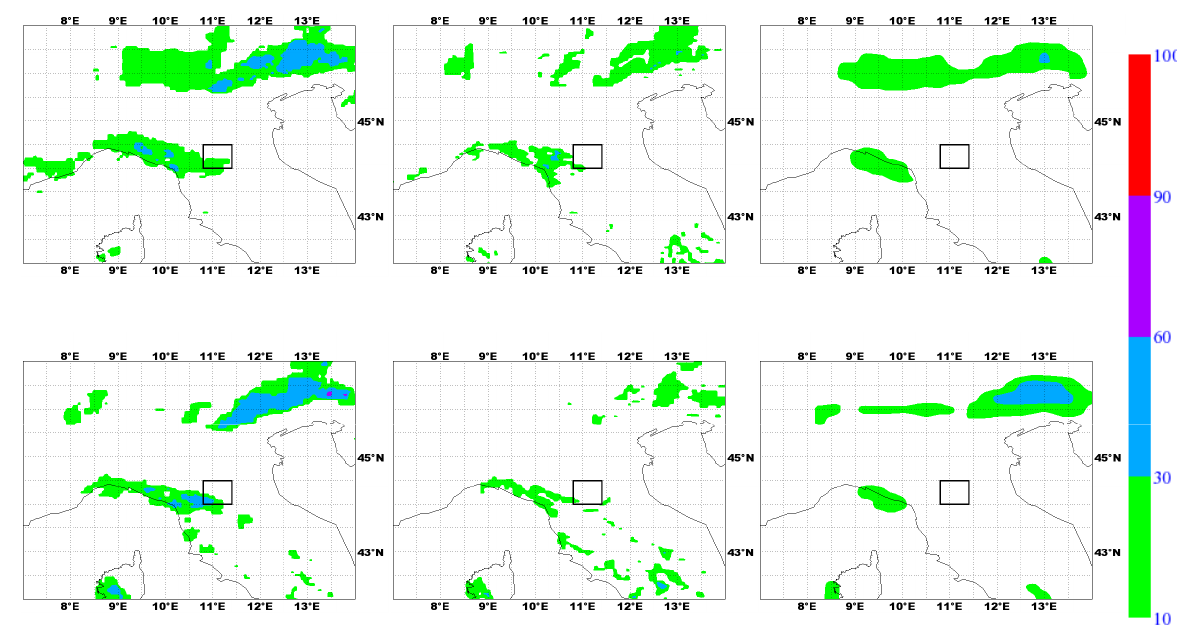
Fig. 5. Maps of probability of precipitation exceeding 50mm in 24h obtained at + 120h (top panels) and + 72h (bottom panels) forecast range: multi-model (left), COSMO-LEPS (middle) and ECMWF global EPS (right) forecasts at 12:00UTC, 1 December 2008.